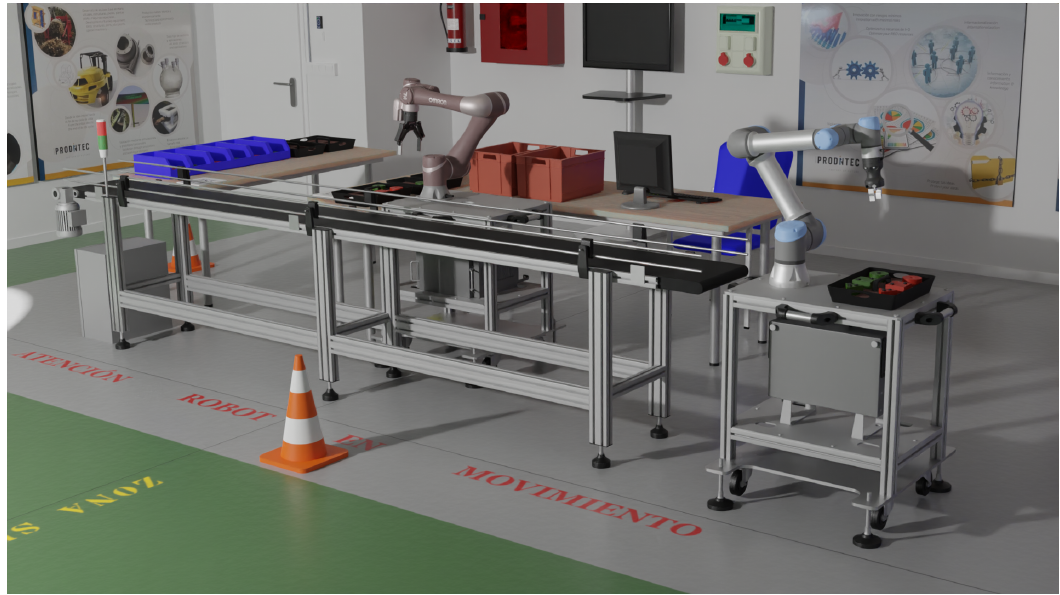
Figure 8. General view of the virtual